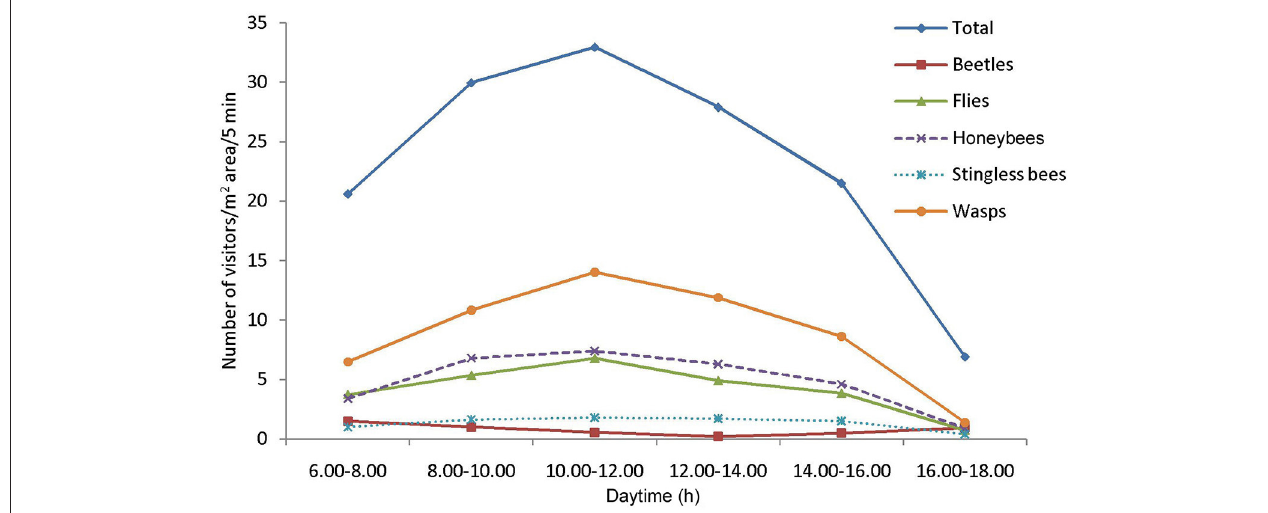
FIGURE 4 | Daytime wise abundances of different insect groups on fennel in West Bengal.